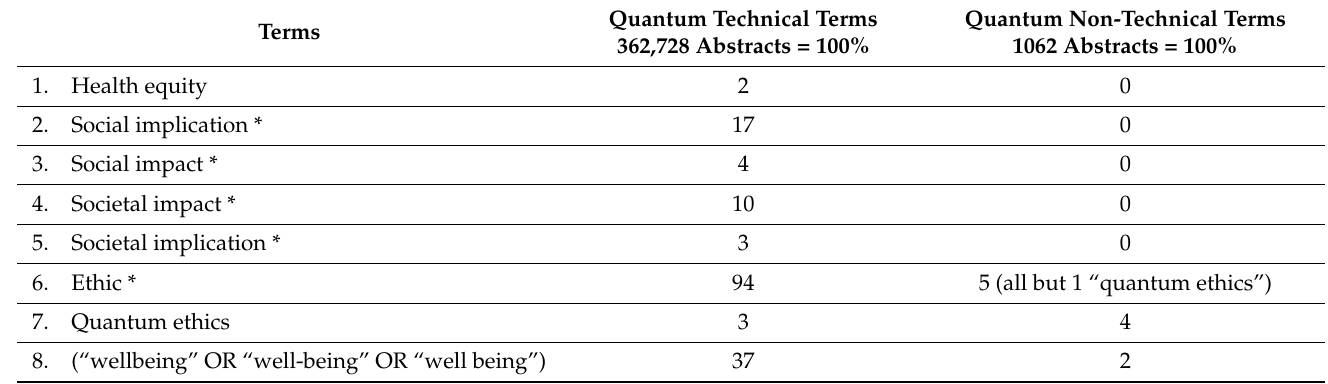
Table 2. Hit counts for terms linked to the ‘social’ in conjunction with quantum terms covered.